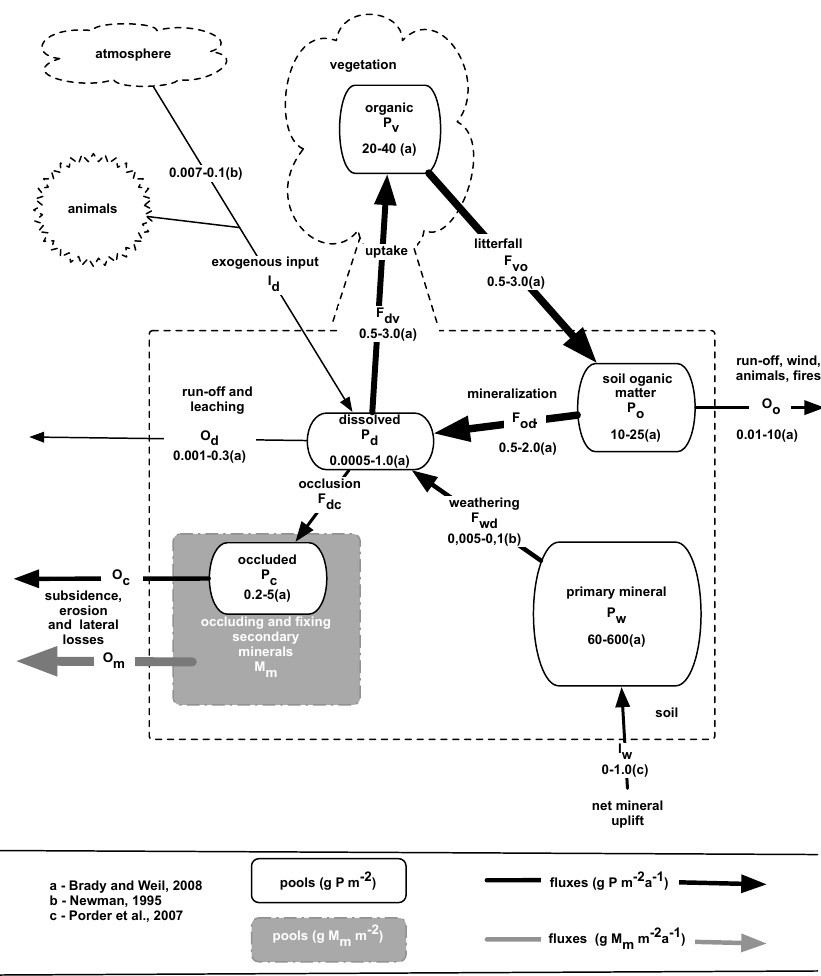
Fig. 1. Schematic representation of the terrestrial phosphorus cycle as described mathematically using Eqs. (12–17). Sizes of the fluxes and pools are taken from the literature (Brady and Weil, 2008; Porder et al., 2007; Newman, 1995). The thickness of the arrows relates to the size of the